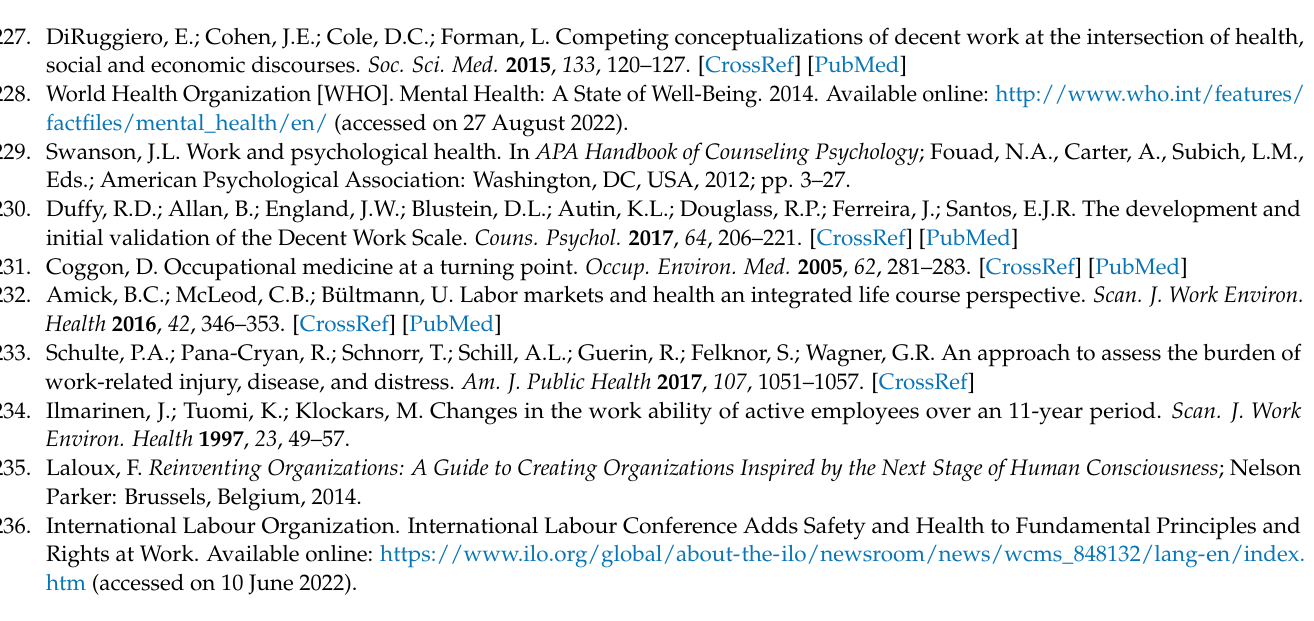
Parker: Brussels, Belgium,